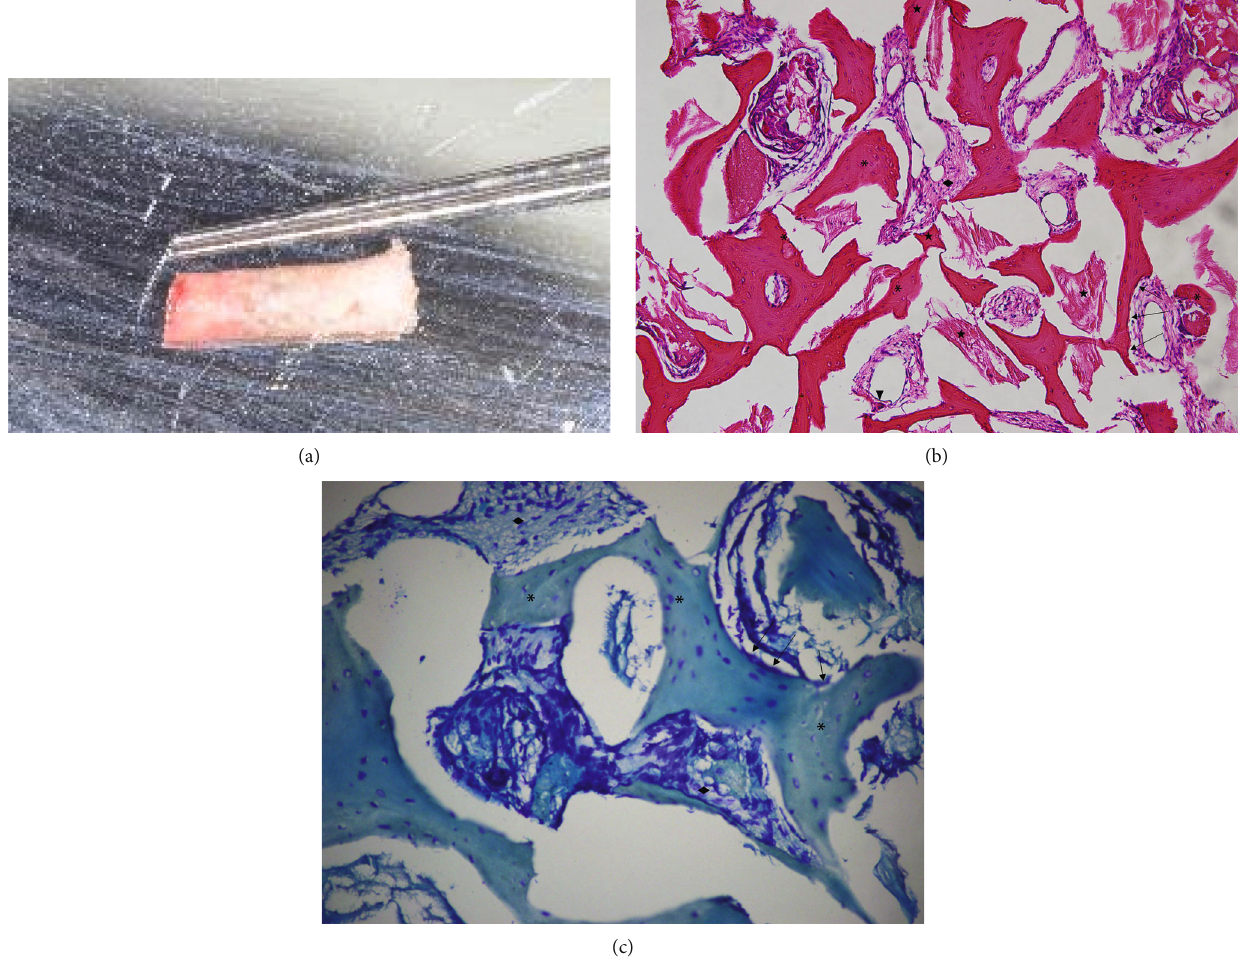
Figure 11: Histological evaluation of tooth #16. (a) The biopsy sample. (b) Representative section stained with hematoxylin-eosin (H&E) ( × 10). (c) Representative section stained with modi fi ed Mallory aniline blue ( × 20). Newly formed bone (asterisk), nonvital bone (star), blood marrow (diamond), bone lining cells (arrowhead), and an osteoclast (arrow) are